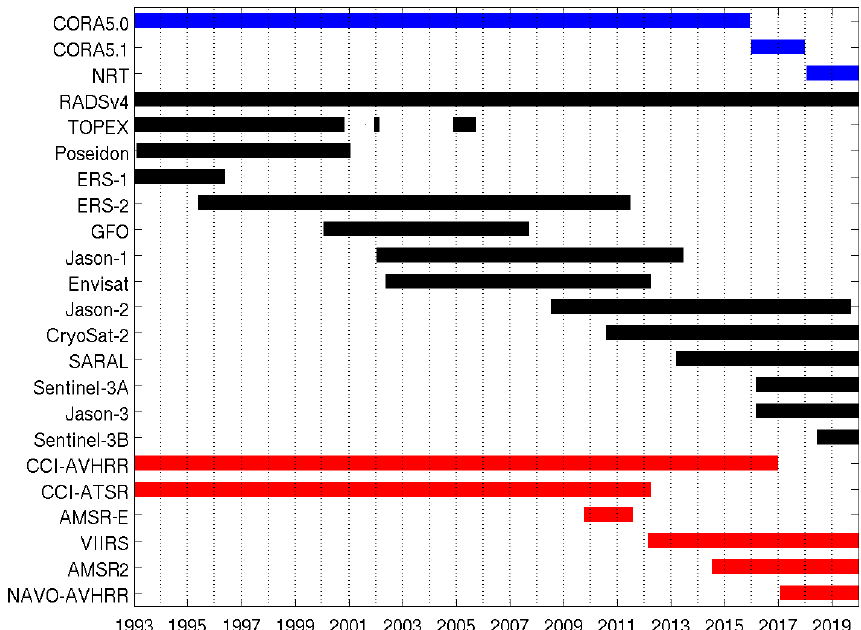
Figure 1. Gantt chart showing when data from different types and sources are assimilated into BRAN2020. Altimeter data are accessed from RADSv4, accessing data from 13 different satellite altimeters (black bars). SST data are accessed from five different sources (red bars), including data from individual satellites (VIIRS, AMSR-E, AMSR2) and from datasets that have combined AVHRR and ATSR data from multiple satellites (CCI AVHRR, CCI ATSR and NAVO AVHRR). In situ data are accessed from three sources – two from the Copernicus Marine Environment Monitoring Service (CMEMS; Coriolis Ocean Dataset for Reanalysis, CORA5.0 and CORA5.1) and a near-real-time dataset maintained by the Bureau of